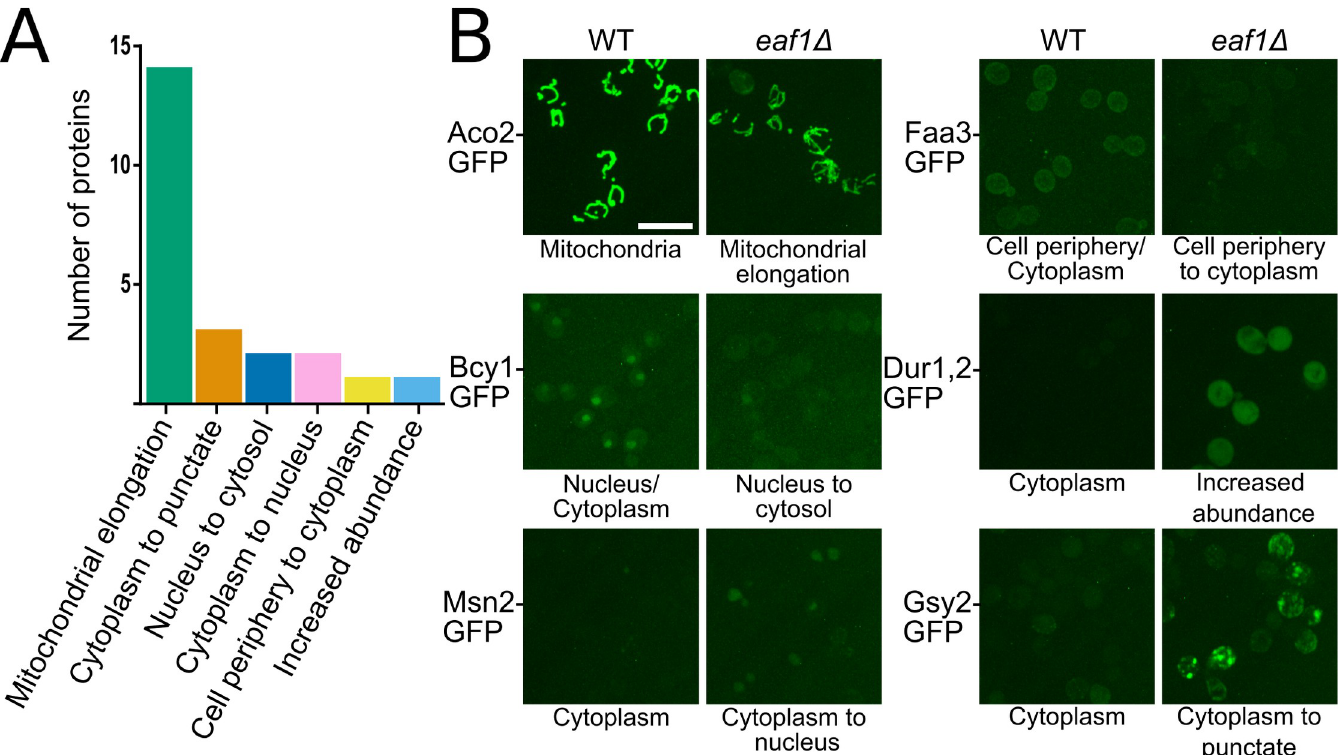
Fig 1. Summary of impact of EAF1 deletion on metabolic protein localization and signal. (A) A phenomic screen for changes in protein localization and abundance between WT and eaf1 Δ yeast was performed using SGA technology and high throughput microscopy. 23 confirmed changes in GFP signal localization or abundance were identified and categorized (S2 Table). (B) Six representative images of the change in GFP-fusion proteins identified in the phenomic screen (images of all confirmed changes available in S3 Fig). WT localization of proteins as previously reported at https://thecellvision.org/cyclops/ are listed under the WT image and the change category is listed under the eaf1 Δ image. Some of these proteins also had changes in abundance in the eaf1 Δ relative to WT. Fold changes outside our cut-off were: Aco2 = 0.51, Dur1, 2 = 3.77, and Gsy2 = 1.65. Scale bar = 10 μ m.